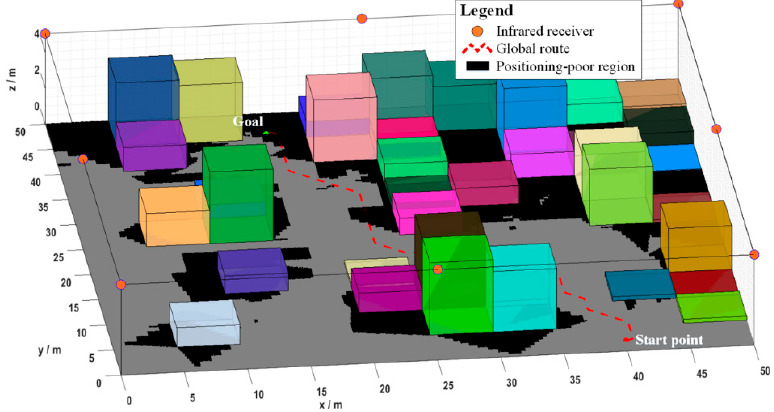
Figure 1. A warehouse workspace with poor positioning regions. Note that there are no kinematically feasible paths if the ego vehicle follows the global route because the goal lies in the poor positioning region.